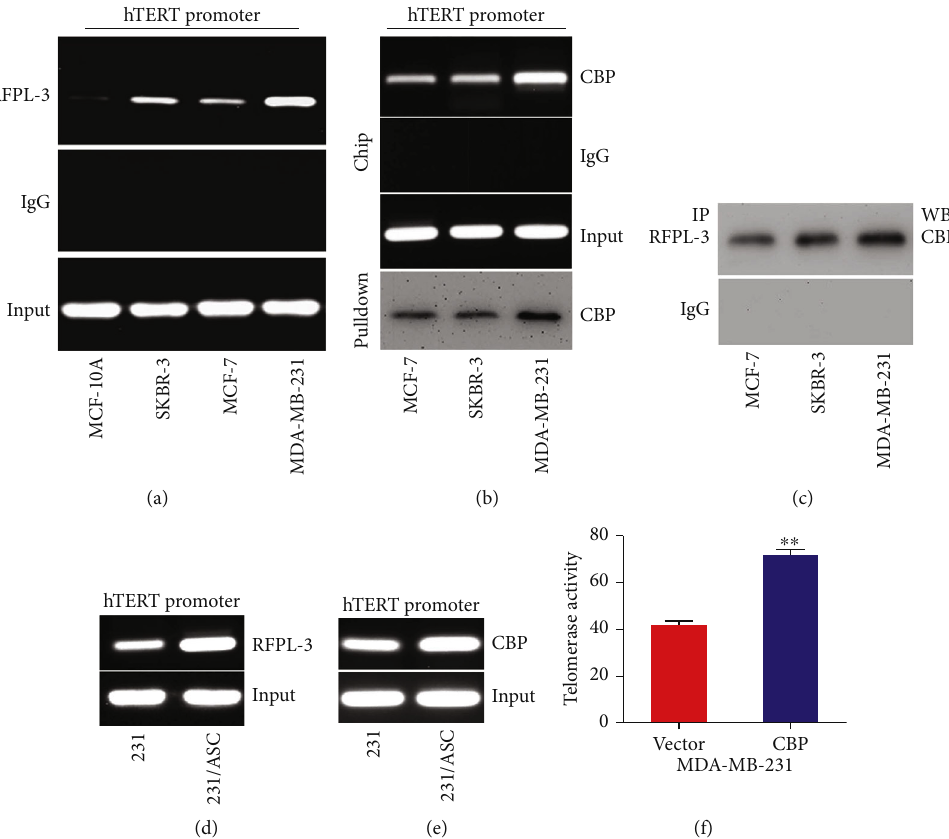
Figure 5: ASC induction of CBP upregulation enhances telomerase activity by activating the binding of RFPL-3 to the hTERT promoter region in breast cancer cells. (a) Chromatin immunoprecipitation assays were performed using anti-RFPL3 in normal breast cells and breast cancer cells. The ampli fi ed products of the hTERT promoter were analyzed by agarose gel electrophoresis. IgG was used as a negative control. (b) Chromatin immunoprecipitation analysis of the proteins bound to the hTERT promoter was performed using anti- CBP in breast cancer cells, and then, the pulled-down protein complex was examined by immunoblotting using anti-CBP. (c) The immunoprecipitation assay of nuclear extracts from breast cancer cells was carried out using anti-RFPL3, and then, the complexes were analyzed by immunoblotting using anti-CBP. (d – e) Chromatin immunoprecipitation analysis of the proteins bound to the hTERT promoter was performed using anti-RFPL3 and anti-CBP in breast cancer cells cocultured with ASCs. (f) The telomerase activity in MDA-MB-231 cells transfected with CBP vectors was measured using a TeloTAGGG telomerase PCR ELISAs. ∗∗ P < 0 : 01